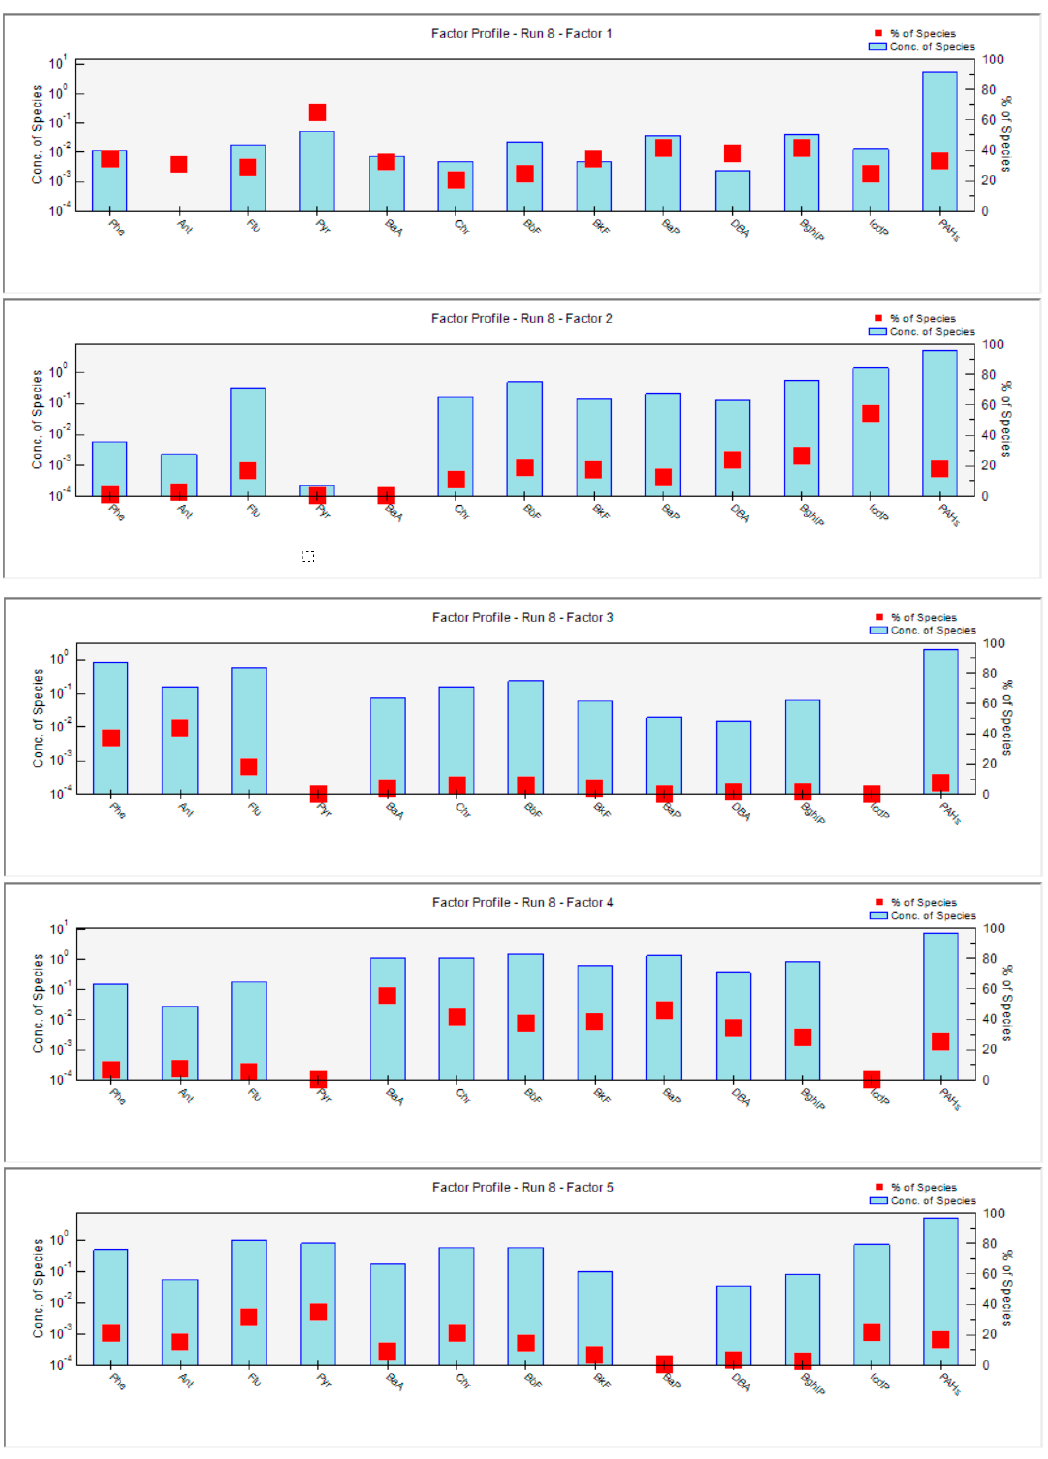
Figure 5. Results of positive matrix factorization.